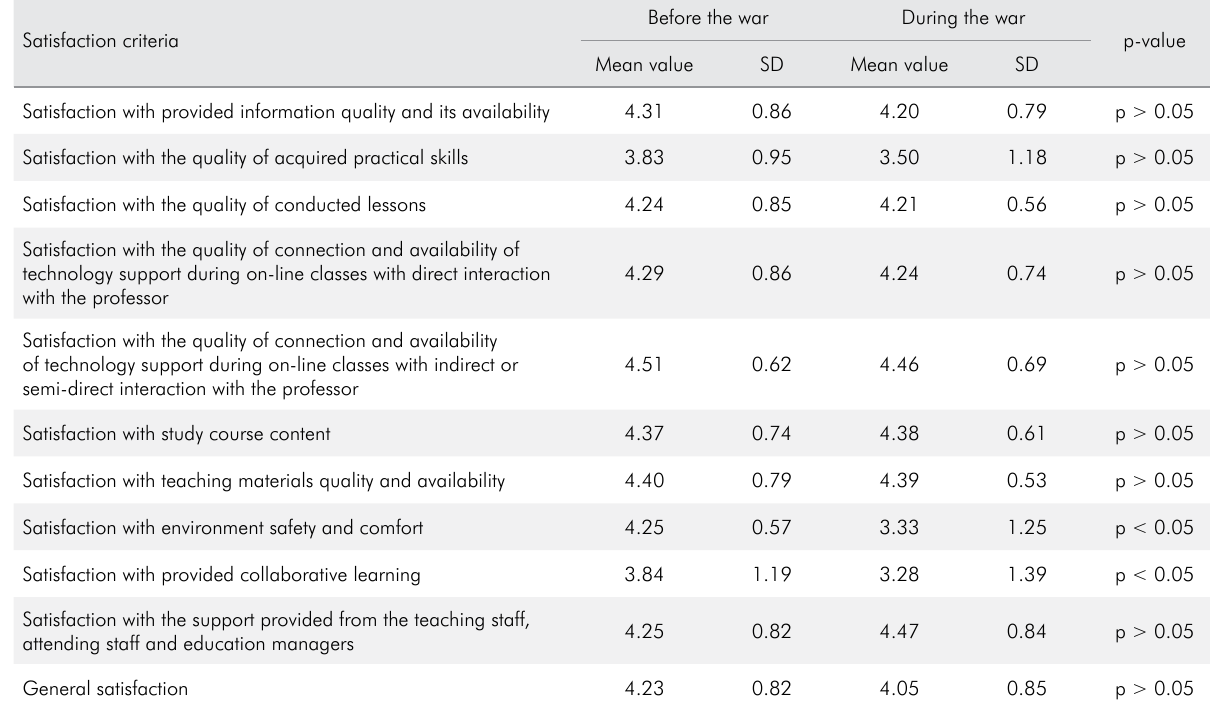
Table 1. Comparison of students’ satisfaction with education quality before the war and during the war. Satisfaction